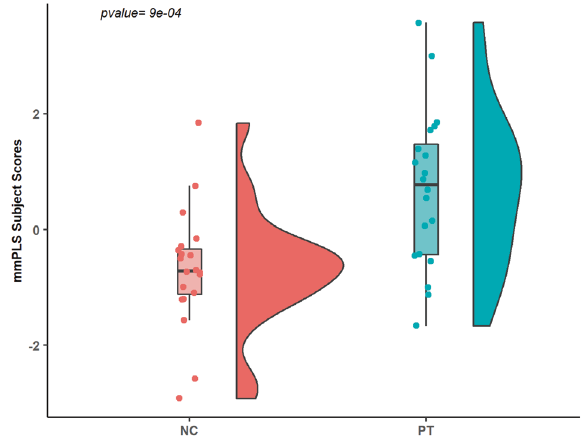
Fig. 2 Subject scores for normal controls (NC) and late-life depressed (PT) patients. Subject scores determined by multi- modal partial least squares.